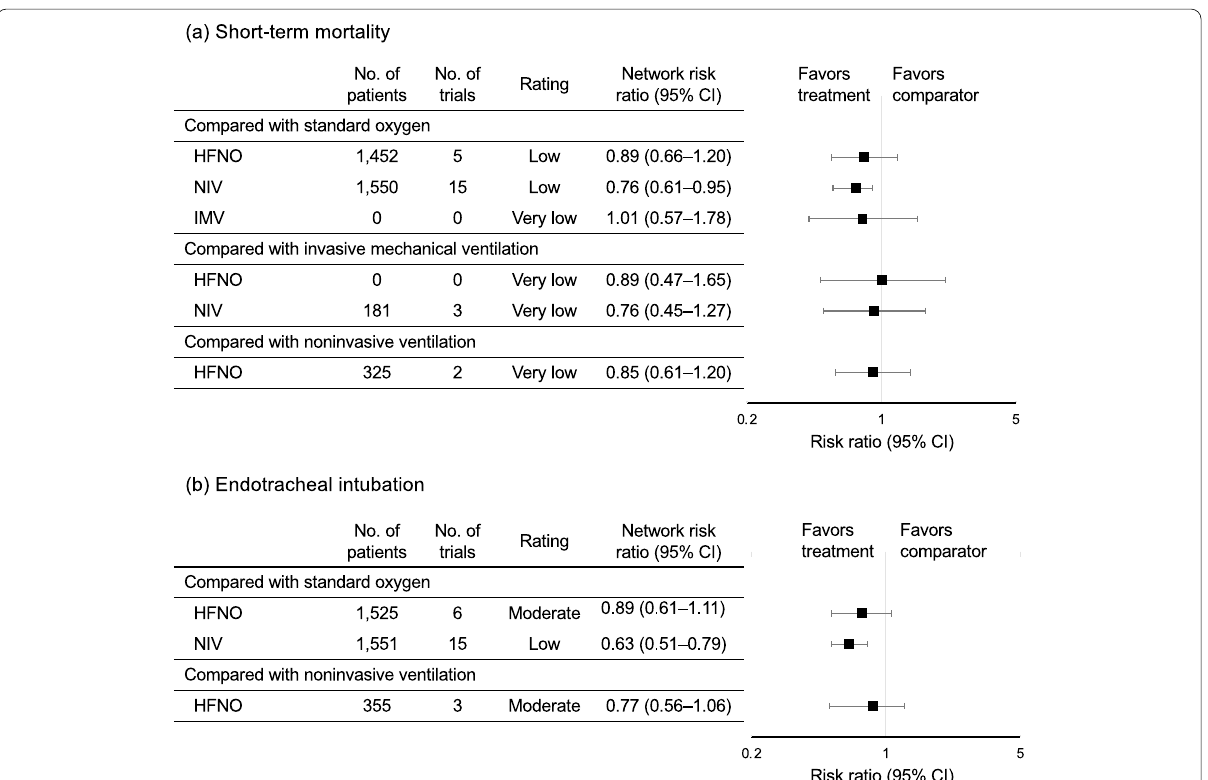
Fig. 3 Forest plots for the association of noninvasive oxygenation strategies with study outcomes. a For the primary outcome, short-term mortality. b For the secondary outcome, endotracheal intubation, all outcomes were reported as network risk ratios and absolute risk differences with 95% confidence intervals (CIs). Risk ratios were estimated for the comparisons of HFNO vs. SOT, NIV vs. SOT, IMV vs. SOT, HFNO vs. IMV, NIV vs. IMV, and HFNO vs. NIV. Abbreviations: CI (confidence interval), HFNO (high-flow nasal oxygen), IMV (invasive mechanical ventilation), NIV (noninvasive ventilation), RR (risk ratio), and SOT (standard oxygen